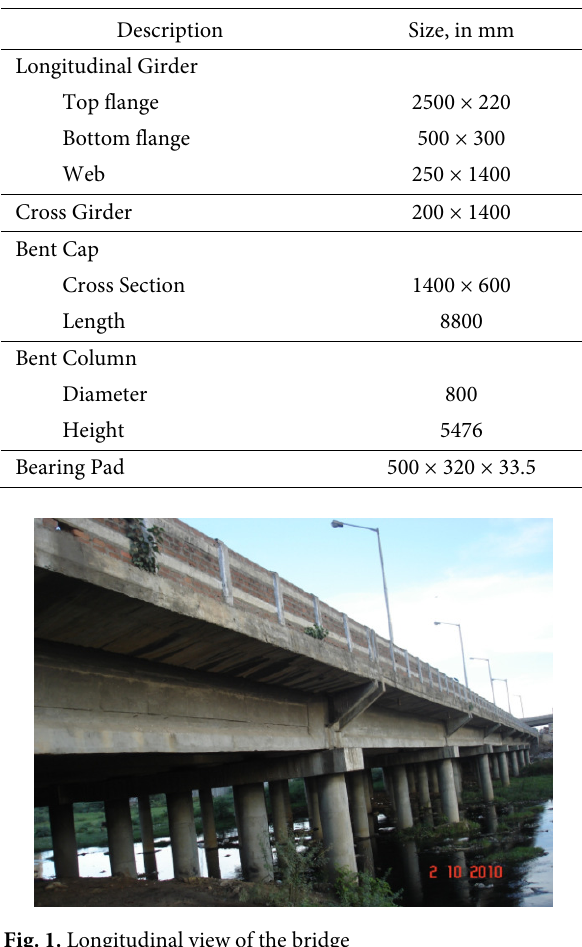
Fig. 1. Longitudinal view of the bridge